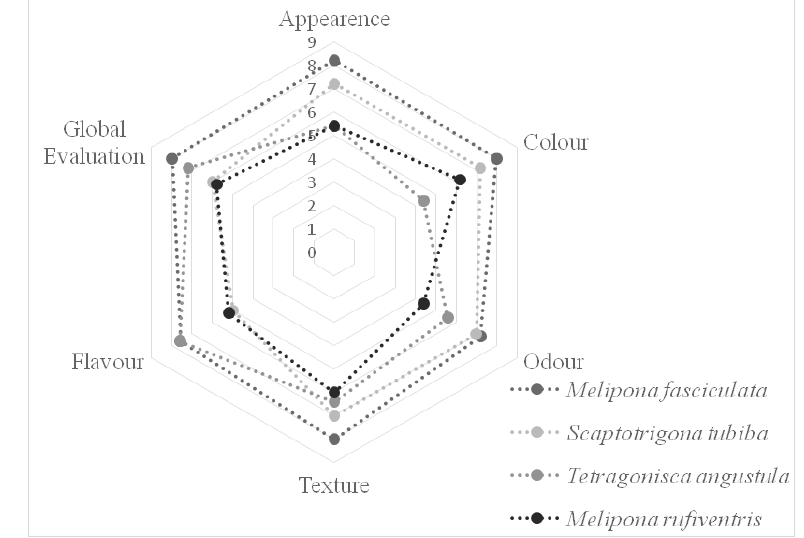
Fig 4 . Sensory analysis of honey produced by stingless bees in the municipalities of Palmas and Miracema in two harvest seasons.